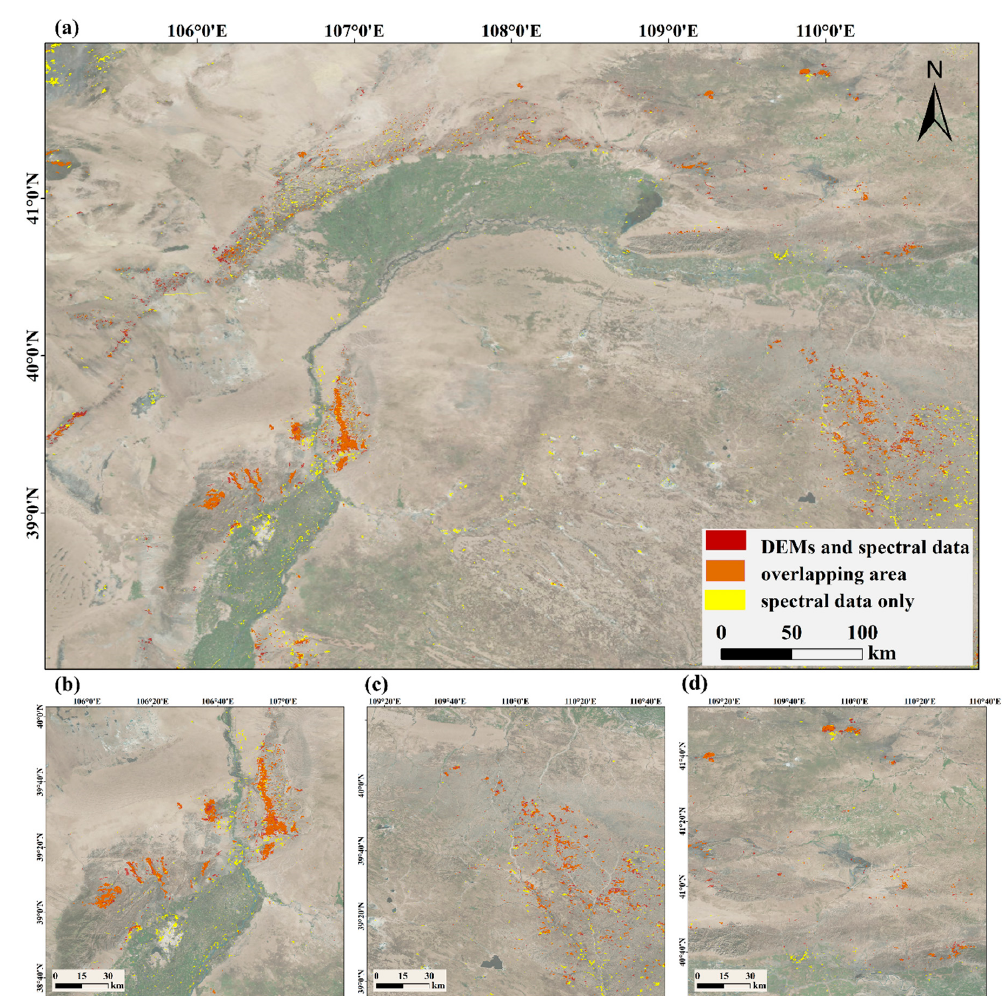
Figure 3. Comparison of mining area identification results on the basis of spectral data combined with Digital Elevation Model data and only spectral data. ( a ) the distribution of mining areas in the whole study area, ( b ) in the southwestern part, ( c ) in the southeast, and ( d ) in the northeast of the study area. The fact that the accuracy measures of Combination I are all higher than that of Combination II (Table 3) indicates that the method of integrating DEM data and spectral imagery (i.e., adding both the topographic and spectral information in the classification) outperforms the method that used spectral data only. Table 3. Precision, recall, overall accuracy, the kappa coefficient, and the F-measure of the confusion matrix based on test data and each superimposed mask of the predicted mines by different combination methods to show the effectiveness. (TP: true positive, TN: true negative, FP: false positive, and FN: false negative). Spectral and DEMs data